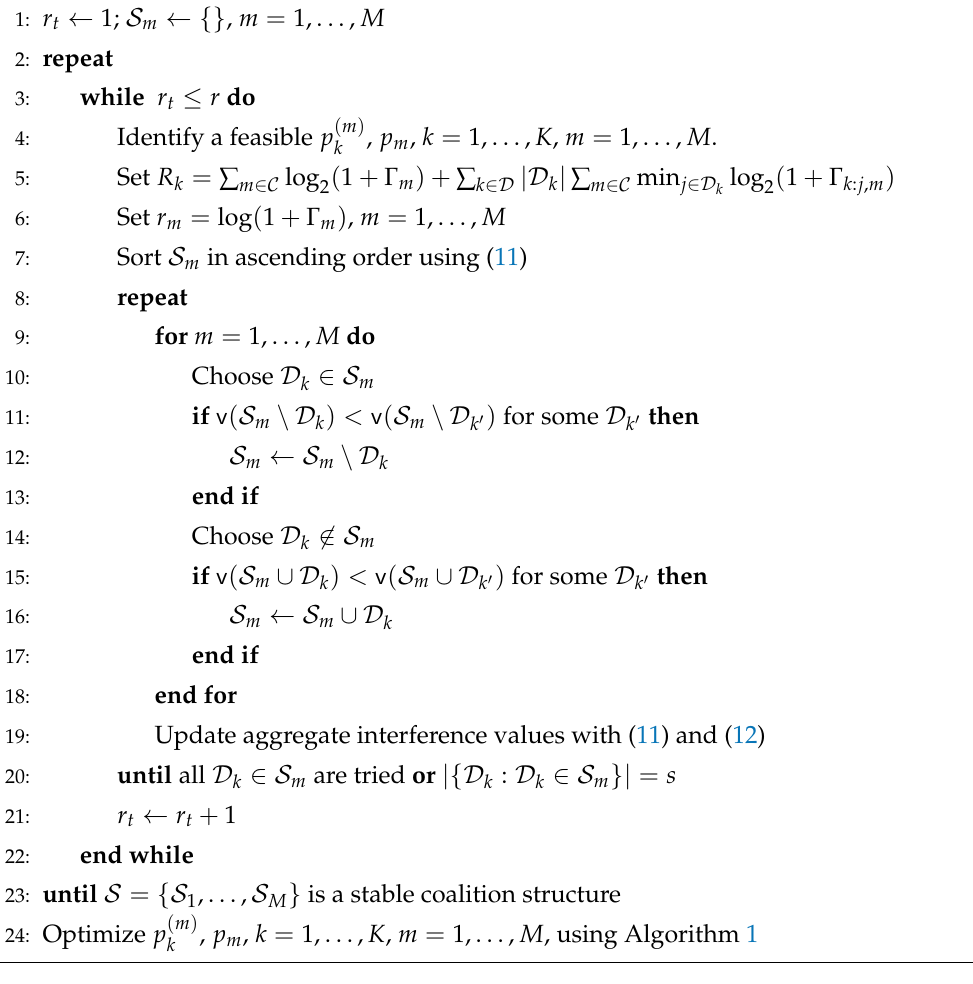
Algorithm 3 NOMA based merge-and-split for the coalitional